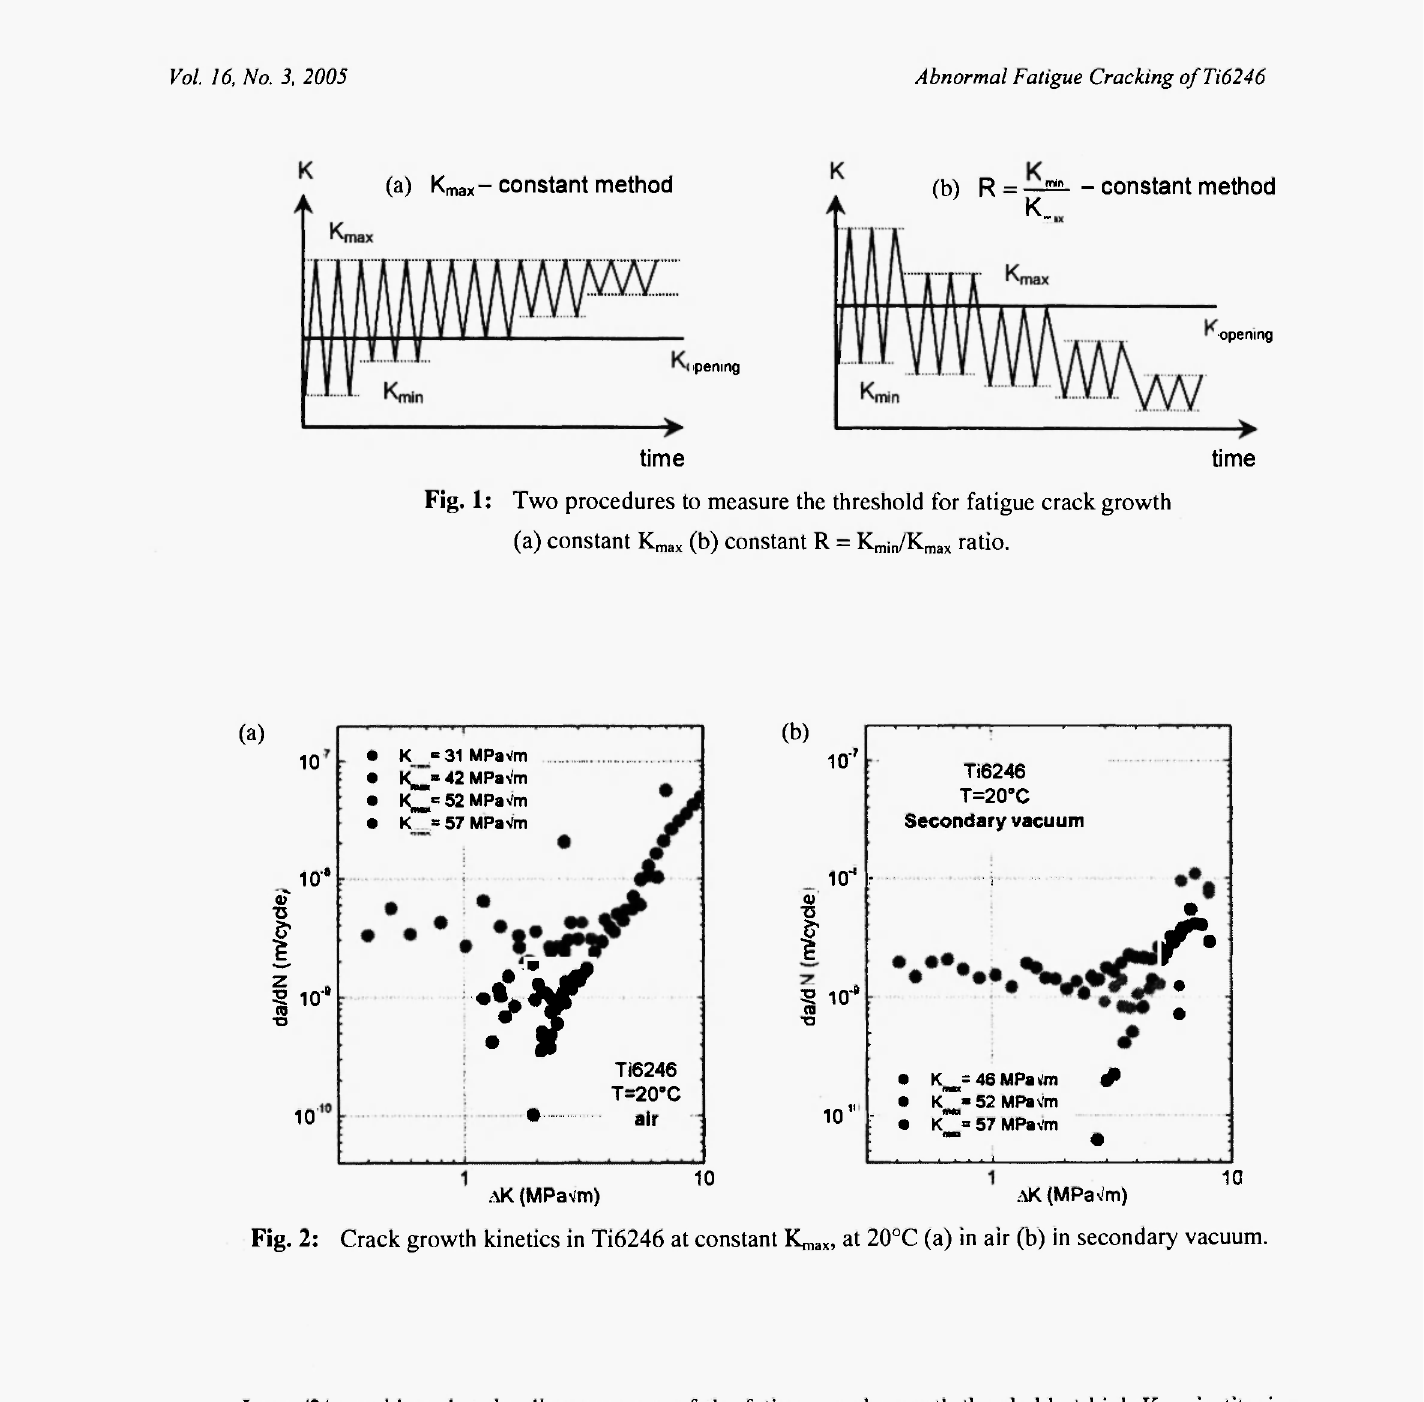
Fig. 1: Two procedures to measure the threshold for fatigue crack growth